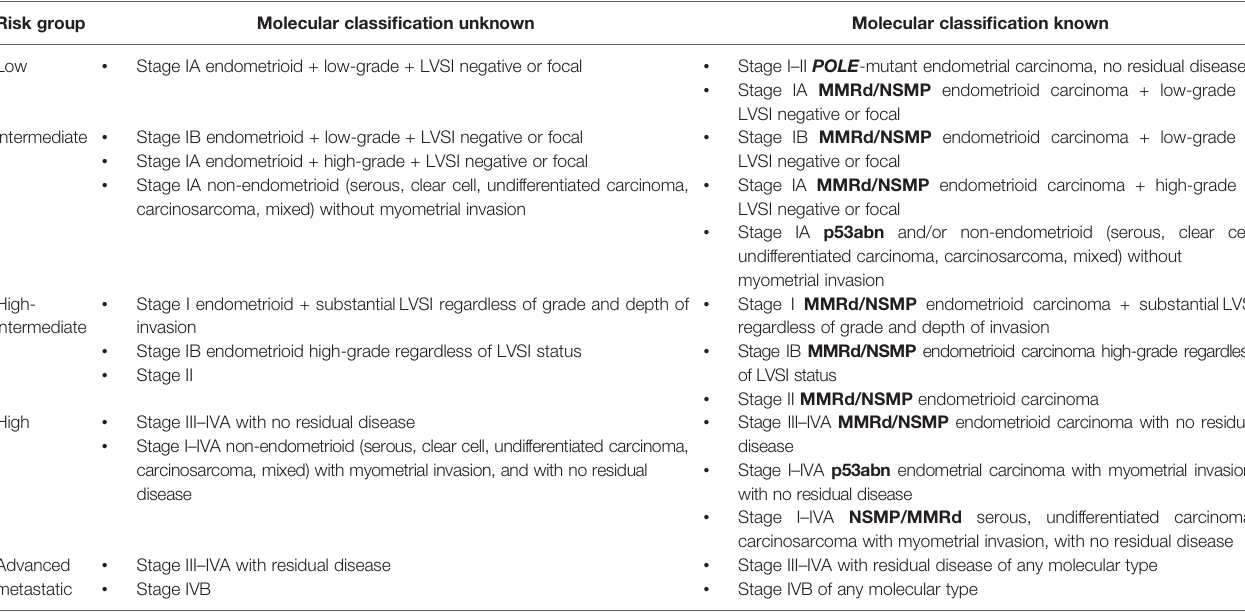
TABLE 2 | Updated ESMO, ESTRO and ESGO endometrial cancer risk strati fi cation algorithm (27). Risk group Molecular classi fi cation unknown Molecular classi fi cation known